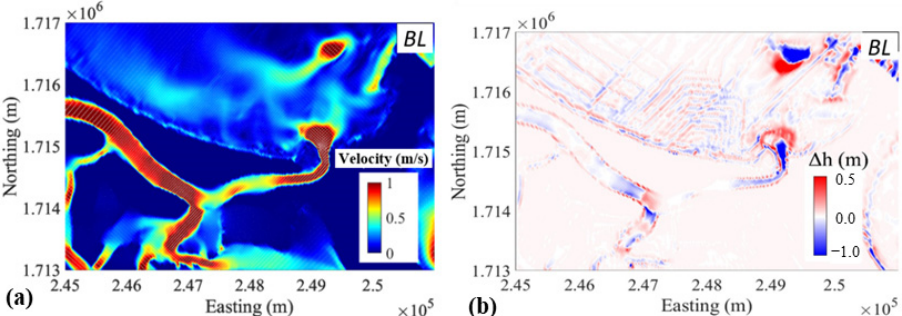
Figure 15. ( a ) Wave field, ( b ) current field under the impact of typhoon Molave—BL scenario.